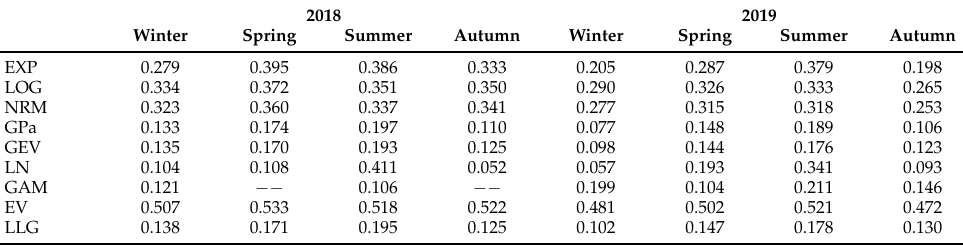
Table 14. KS-test results for the L-moment estimation, for the 300 m threshold.